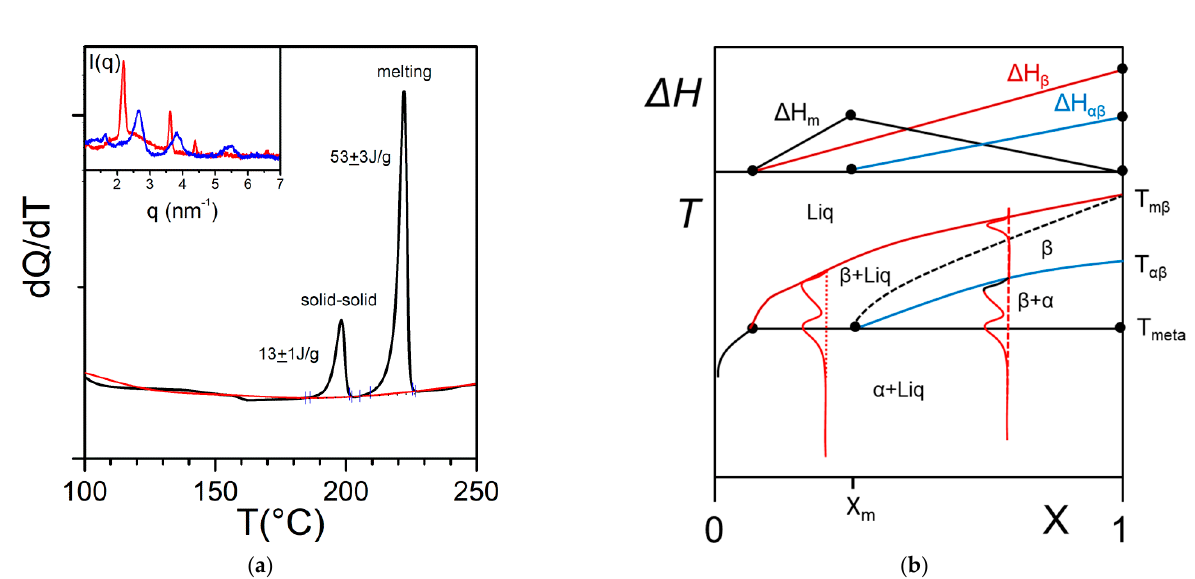
Figure 8. ( a ) The metatectic transformation can exist if there exists two crystalline forms, α form and β form of the gelator in the solid phase (here a tri-aryl tri-amine, TATA, shown in Appendix figure A2). At T αβ = 198 °C the α form transforms into the β form as evidenced by the change of diffraction pattern in the inset: blue line at T = 20 °C, red line at T = 200 °C. ( b ) T-C phase diagrams for a metatectic transformation. The red lines show the corresponding DSC traces. The Tamman’s diagram for the enthalpies associated with the different thermal events is shown on top.